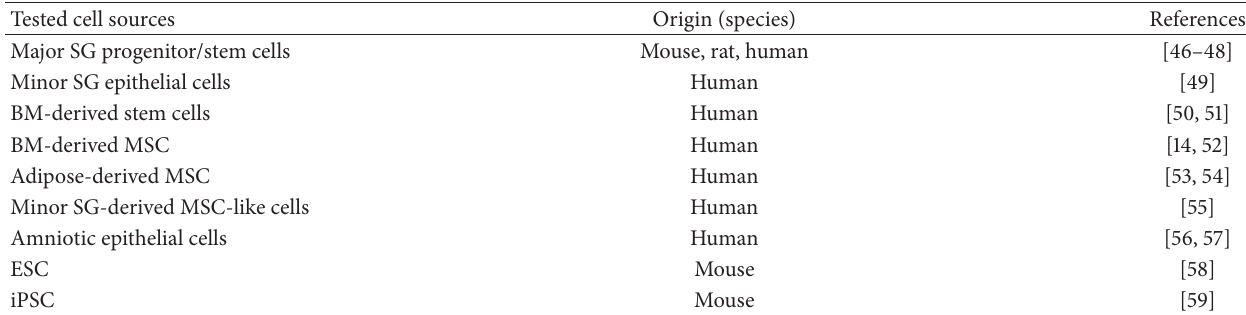
Table 2: In vivo and in vitro tested oral stem cell lines for salivary gland regeneration. SG: salivary gland, BM: bone marrow, MSC: mesenchymal stem cells, ESC: embryonic stem cells, and iPSC: induced-pluripotent stem cells.